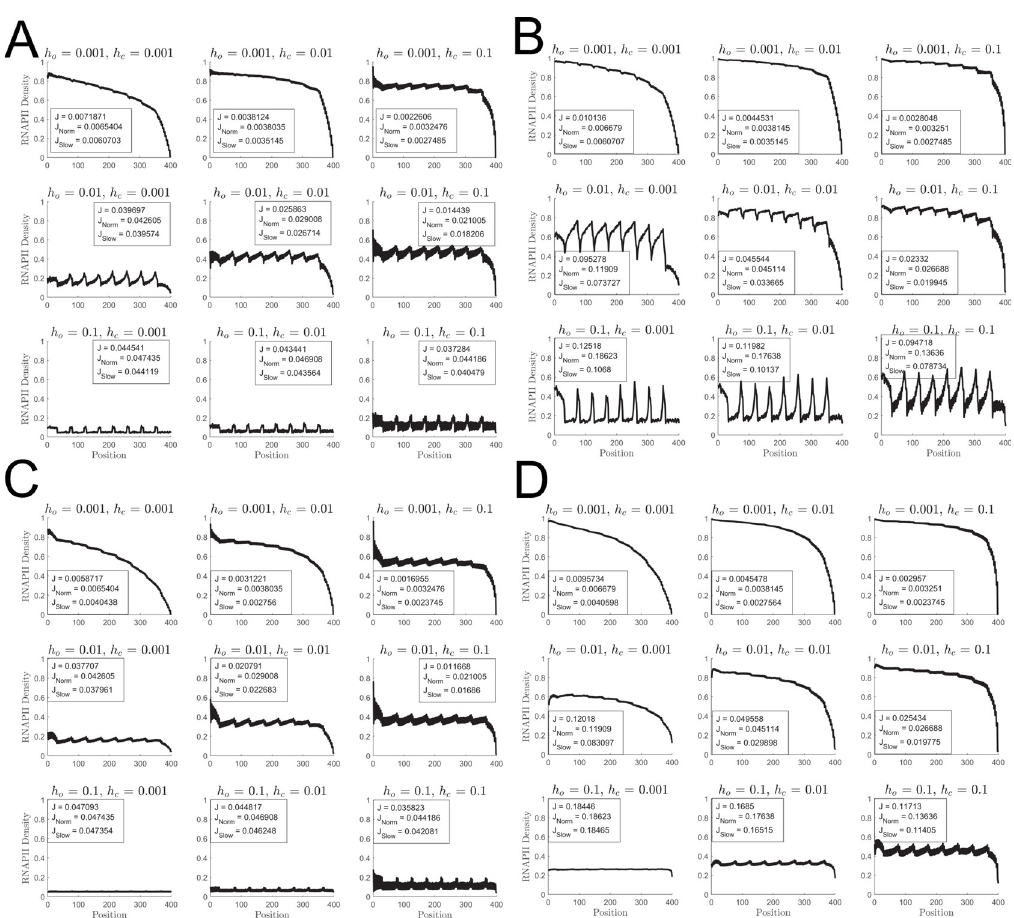
Fig 9. Effects of static defects and nucleosome rate constant variability on RNAPII density profiles. All subpanels have h c increasing from 0.001 to 0.1 from left to right and h increasing from 0.001 to 1 from top to bottom as in Fig 2. 50 replicates of o N MCS = 2 × 10 6 Monte Carlo steps are performed for all cases. All plots list the simulated flux J , the theory prediction for the unperturbed system J , and the theory prediction based on the slowest site J . The left column (A, C) contains simulations Norm slow at a low initiation rate of α = 0.05 while the right column (B, D) contains simulations at α = 0.25 which is saturating for the slow sites. The top row (A, B) shows density profiles from a gene with static defects representing a CpG Island (32 sites) on the promoter and 7 exons (8 sites) with a static defect advance rate of q = 0.5 q on these sites with additional GC content i heterogeneity given by Eq 48 leading to a minimum advance rate q s = 0.43. The bottom row (C, D) shows density profiles from the same gene, but the variability is introduced through the rate constants h and h . GC content heterogeneity is o , m c , m introduced via Eqs 49 and 50. On the CpG Island and exon sites, h c , m is increased by 25%, and h o , m is decreased by 25%. With the addition of GC content heterogeneity, the maximum observed max( h ) was 27% higher than the average, and the c , m minimum observed min( h o , m ) was 26% lower than the